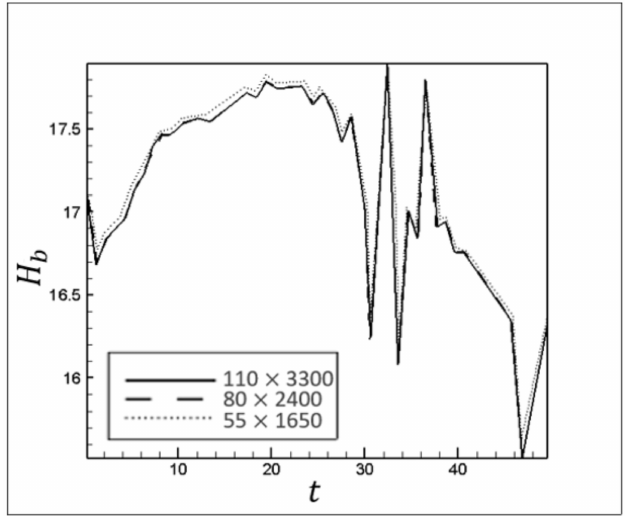
Figure 6. The effects of changes in the lattice layout on the mean thickness of the static layer left on the lower wall of the channel at different